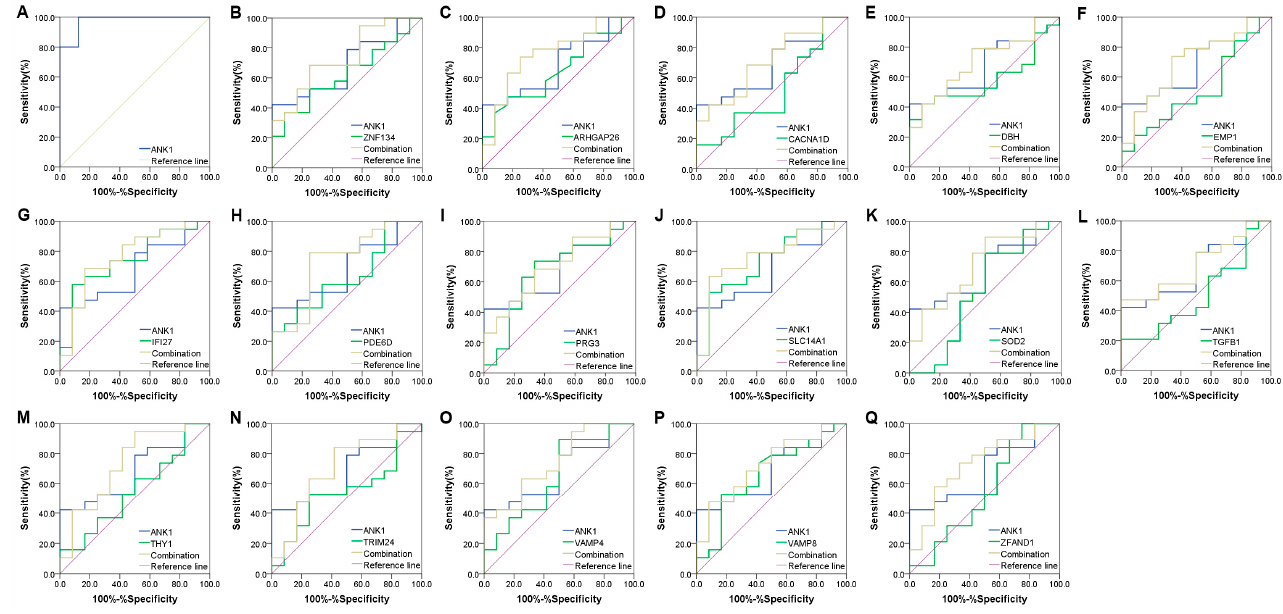
Figure 4. Diagnostic performance of ANK1 in PD. ( A ) Receiver operating characteristics (ROC) analysis to evaluate the performance of ANK1 as a diagnostic biomarker in GSE 22491. ( B – Q ) ROC curve to evaluate the diagnostic accuracy of ANK1 and the combined diagnosis in GSE 34287. Table 1. Gene ontology analysis of differentially expressed genes associated with ANK1